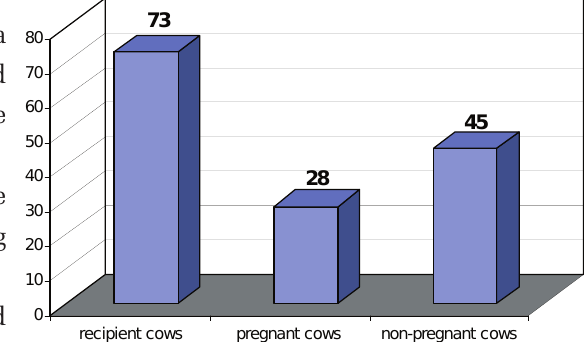
Chart 1. Pregnancy rate in batch 1